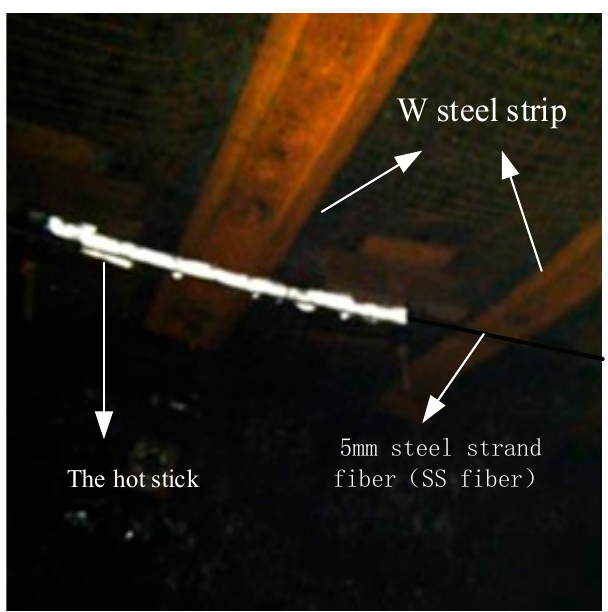
Sensors 2020 , 20 , 1318 22 of 32